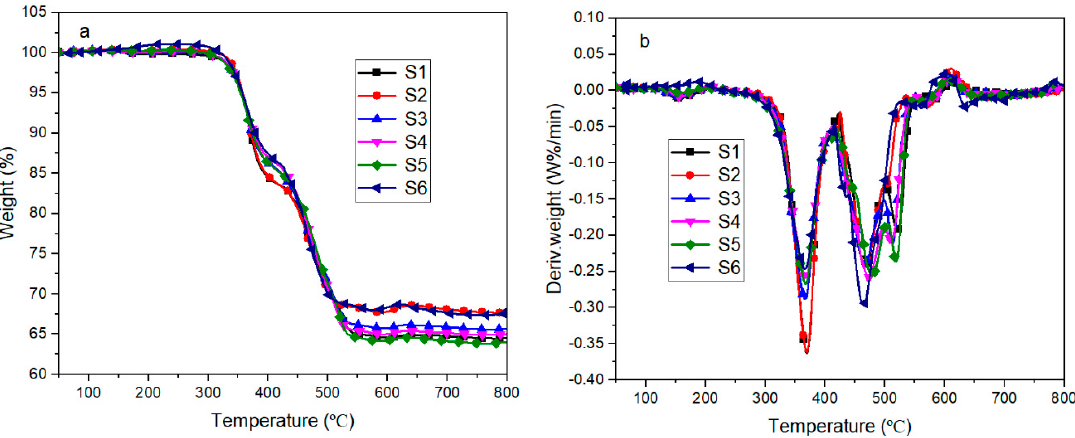
Figure 13. TGA ( a ) and DTG ( b ) curves of SIFs with different MAPOSS content under an air atmosphere. Table 2. The thermo-oxidative stability of polysiloxane foam with different MAPOSS content.